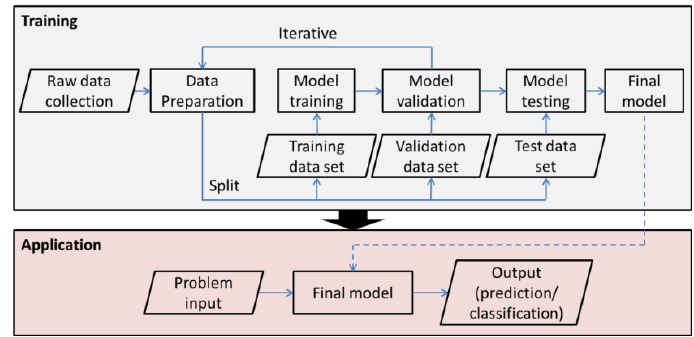
Figure 4. Supervised machine learning implementation process